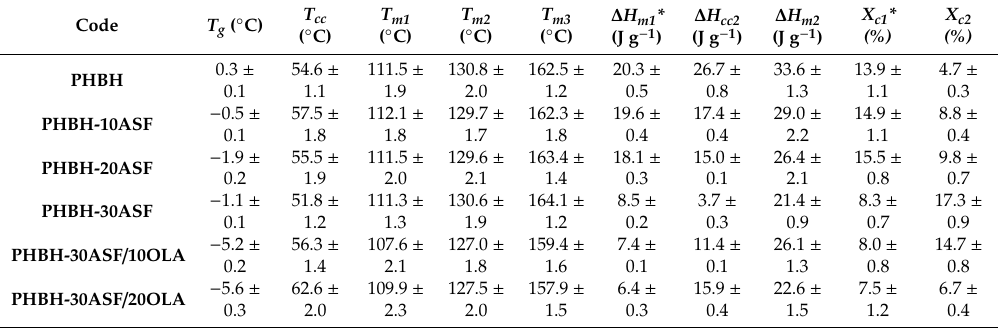
PHBH-30ASF / 10OLA